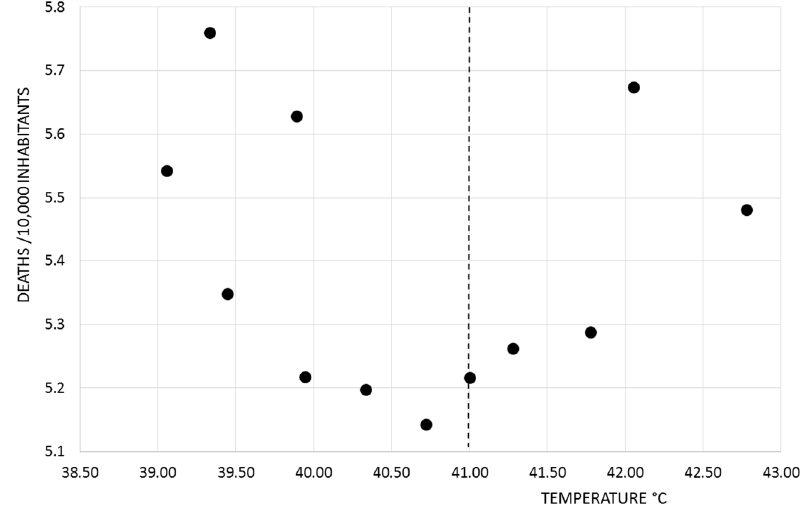
Figure 6. Relationship between mortality rate and max temperatures during August in Maricopa County (2004 to 2015).